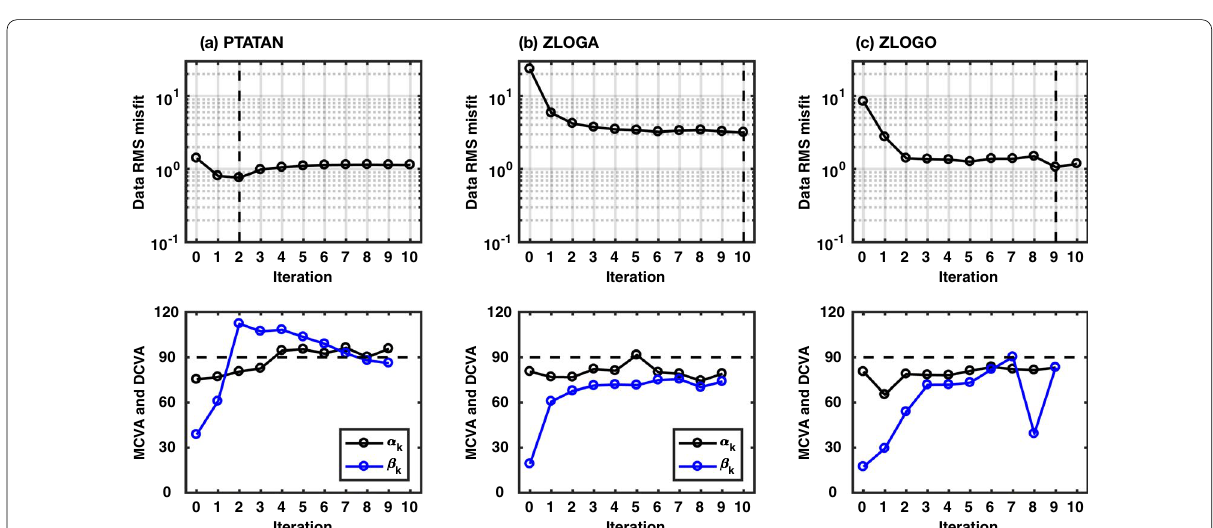
period but may still cause considerable inductive distor- tion. Unlike the galvanic effect, the inductive effect is fre- quency-dependent and exists in the magnetic field as well (e.g., Chave and Smith 1994; Nolasco et al. 1998). Induc- tive distortion in MT data is more problematic than gal- vanic distortion and, therefore, has rarely been dealt with, particularly for on-land observations. Careful interpreta- tion of PT inversion results is recommended, because the inversion of a data set with inductive distortion may cause some artifacts and alteration of the regional model. Checking the LDI before performing inversion is impor- tant in practice, as it diagnoses the presence of galvanic or inductive distortion at each observation site, at least to some extent.